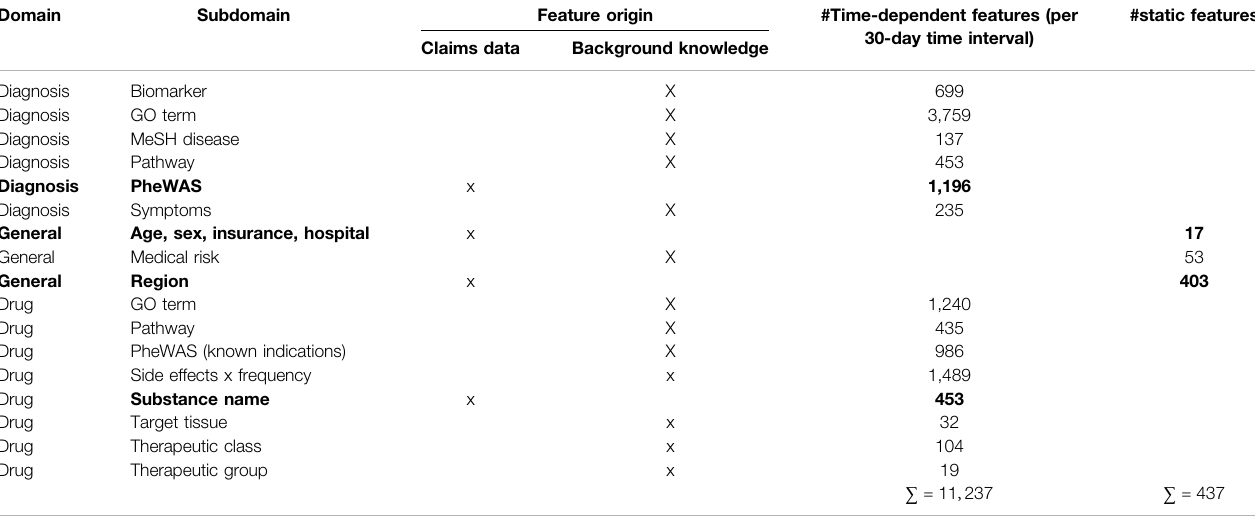
Bold values indicate that the “ Feature origin ” is “ Claims Data ” .